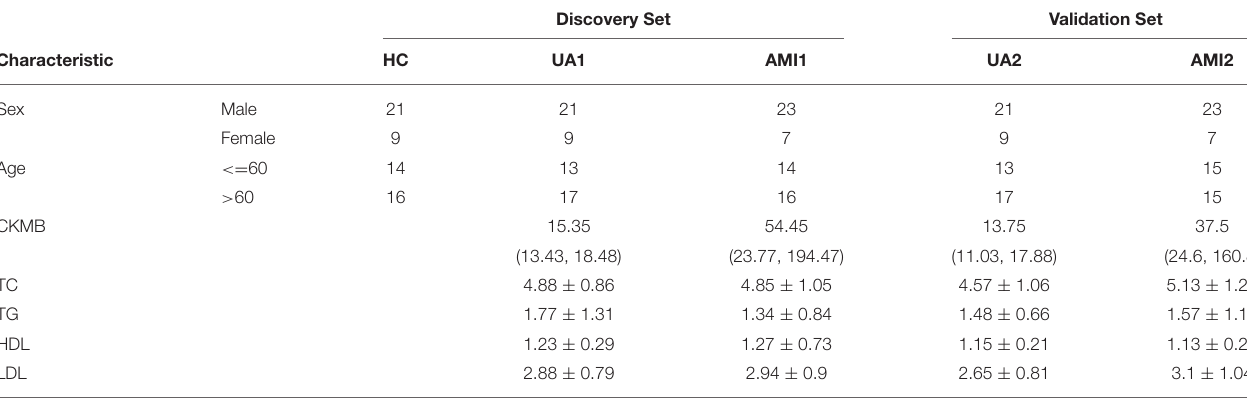
TABLE 1 | The clinical information of patients.